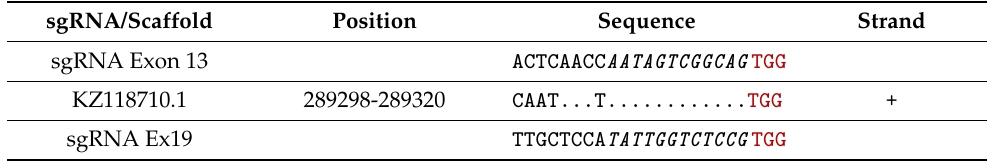
Table 2. Potential off-target sequences for single guide RNA (sgRNA) targeting exon 13 and 19 in the genome of Helicoverpa zea . Scaffold number, nucleotide position, off-target sequence, and the strand of DNA are given. Nucleotides of the protospacer adjacent motif are shown in red bold text and 12-nucleotide seed sequences are shown in bold Italics. Nucleotides identical to each sgRNA are shown by a period.